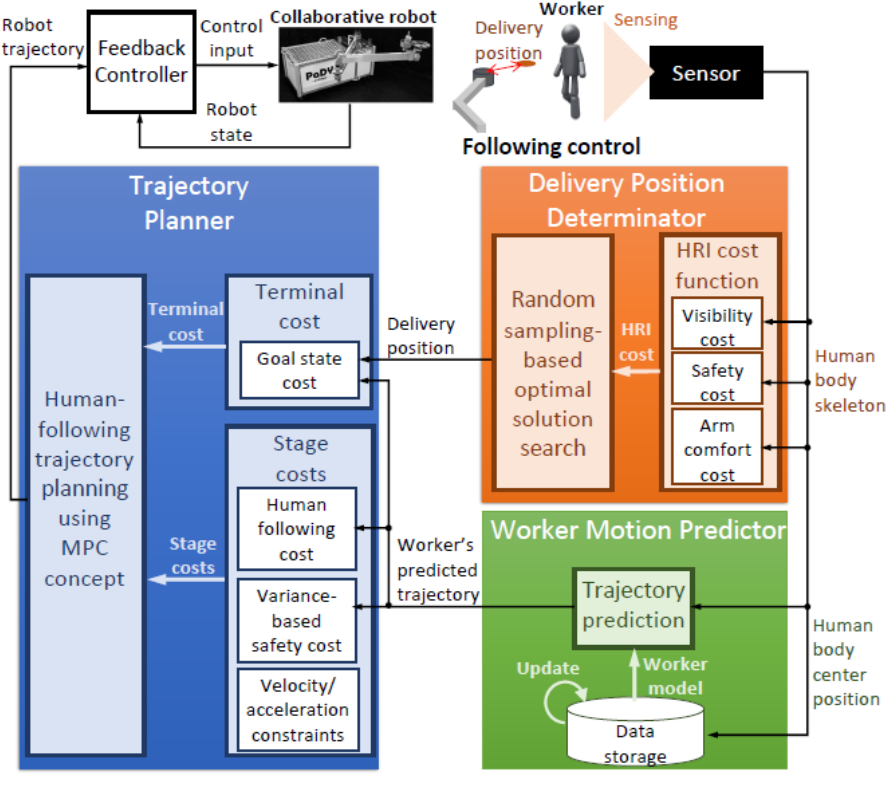
Figure 1. System